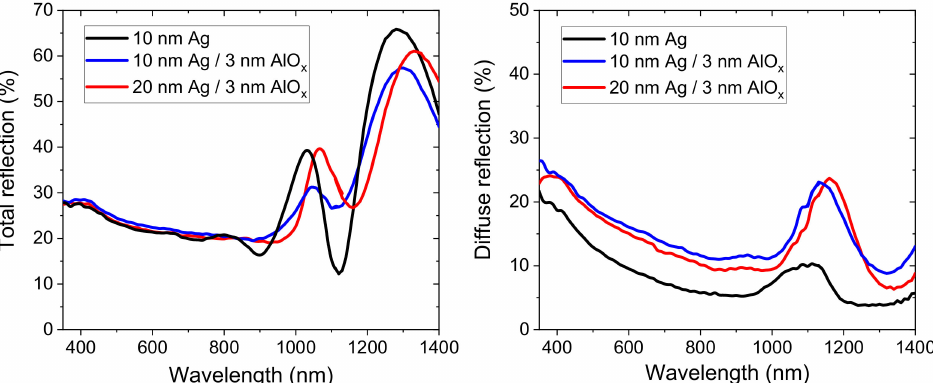
Figure 8. Total ( left ) and diffuse ( right ) reflection of the various absorber layers. In the case of the Ag/AlO x stack at the back, the total reflection shows reduced interference amplitude and increased diffuse